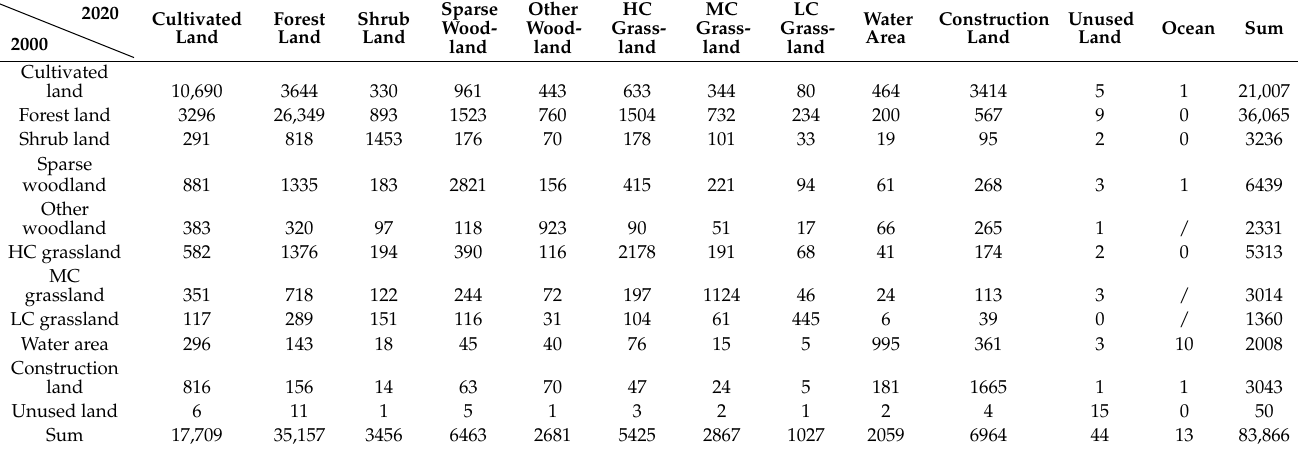
Table 4. The transfer relationship between different land-use types in coastal cities of southeast China over the past 20 years. Numbers in the table are areas of the corresponding sub-types of green space (km 2 ). HC, MC and LC grassland are high-, moderate-, and low-coverage